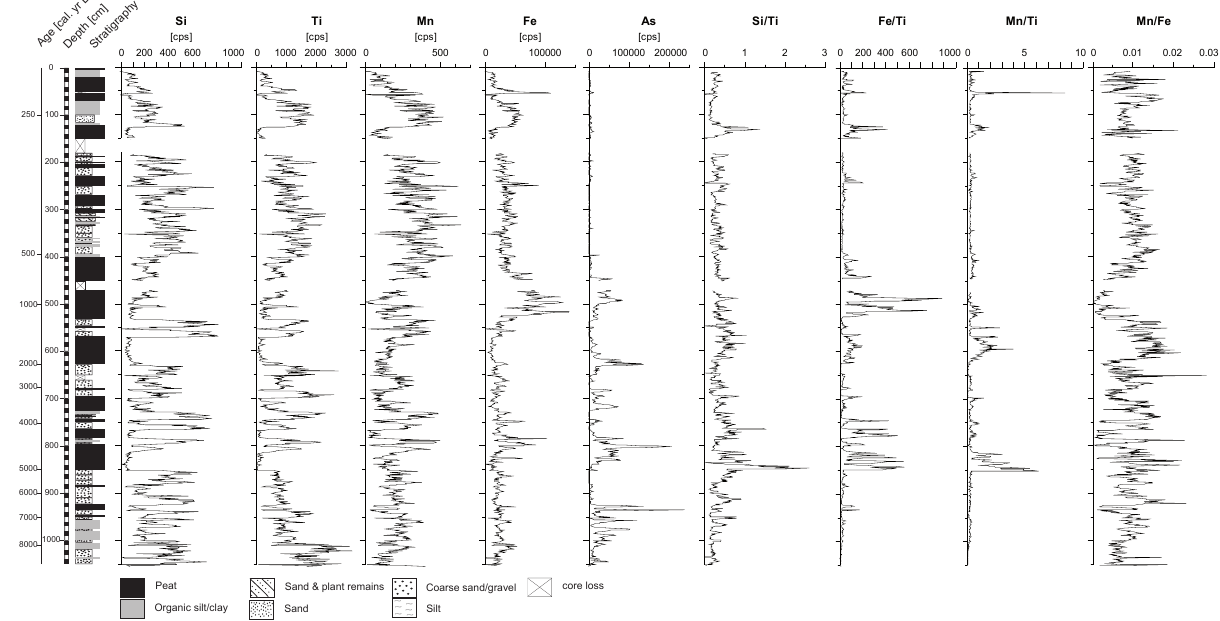
Figure 3. Stratigraphy and selection of elements and elemental ratios measured by the XRF core scanner for core Pe852 of the Cerro Llamoca